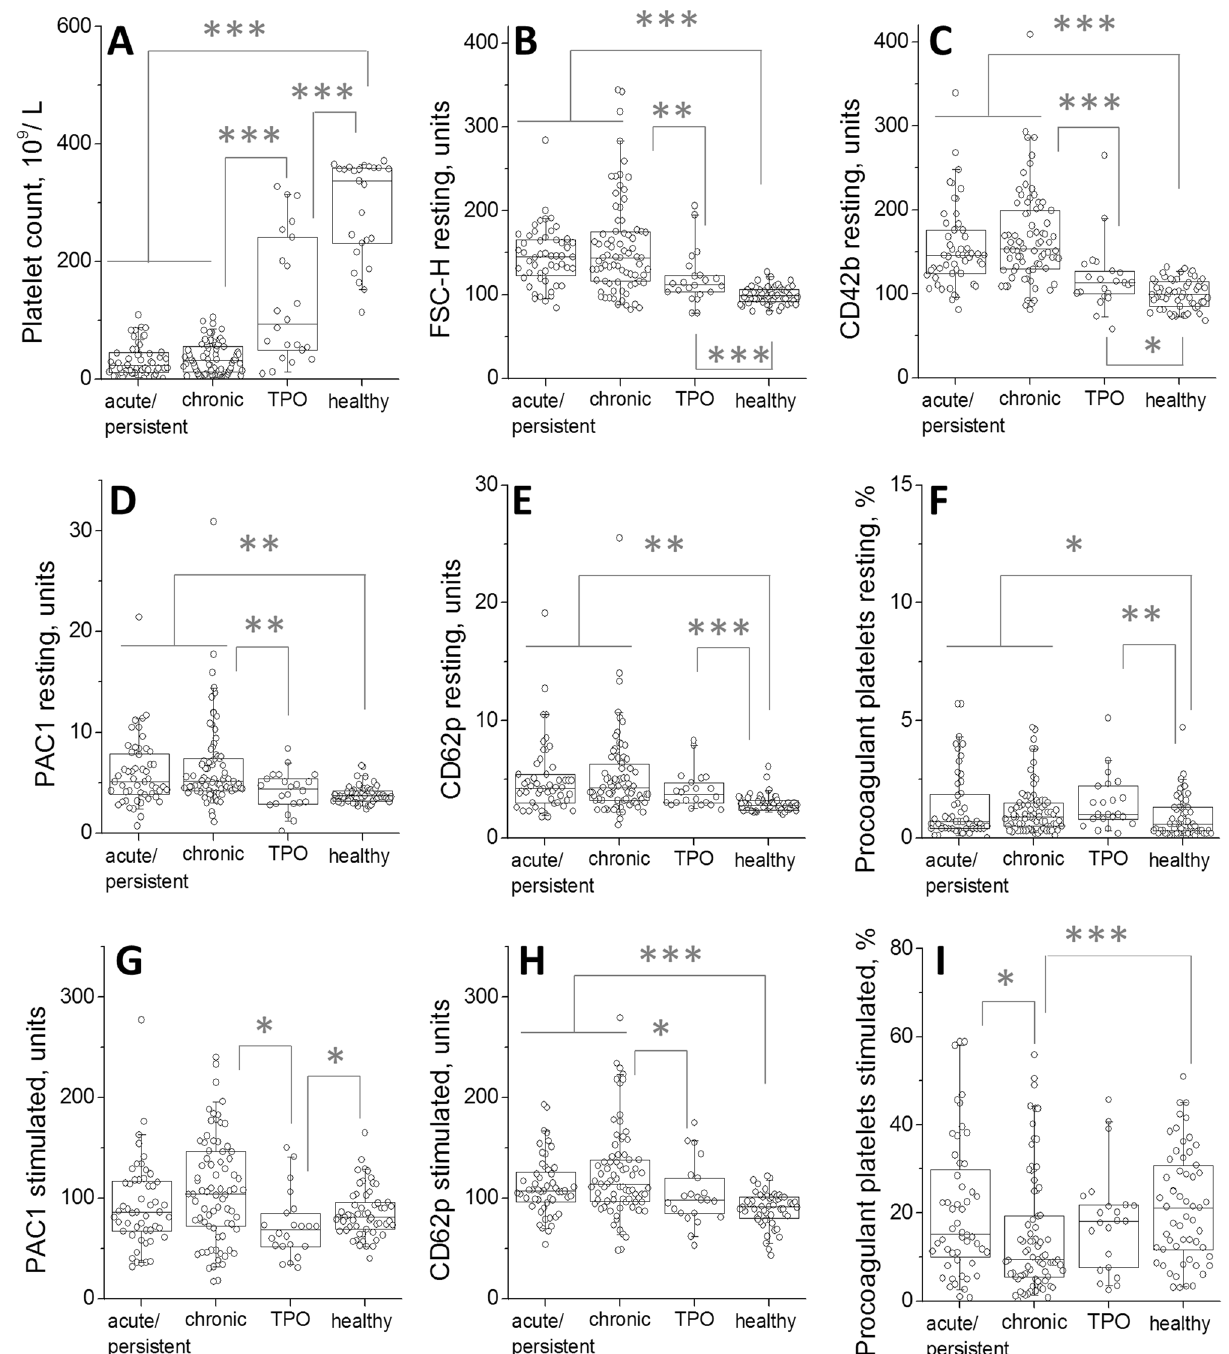
Figure 1. Platelet function in acute/persistent and chronic ITP, and the effects of romiplostim. The panels show platelet parameters (in resting state and upon dual stimulation by CRP + TRAP-6 mixture) for either acute/ persistent ITP, chronic ITP, ITP on romiplostim (labeled as TPO), or healthy children. The data points are the circle symbols, horizontal lines are medians, boxes show 25th–75th percentiles, error bars show 5–95% intervals. Statistical significance is shown by asterisks: *, p < 0.05, **, p < 0.01; ***, p <